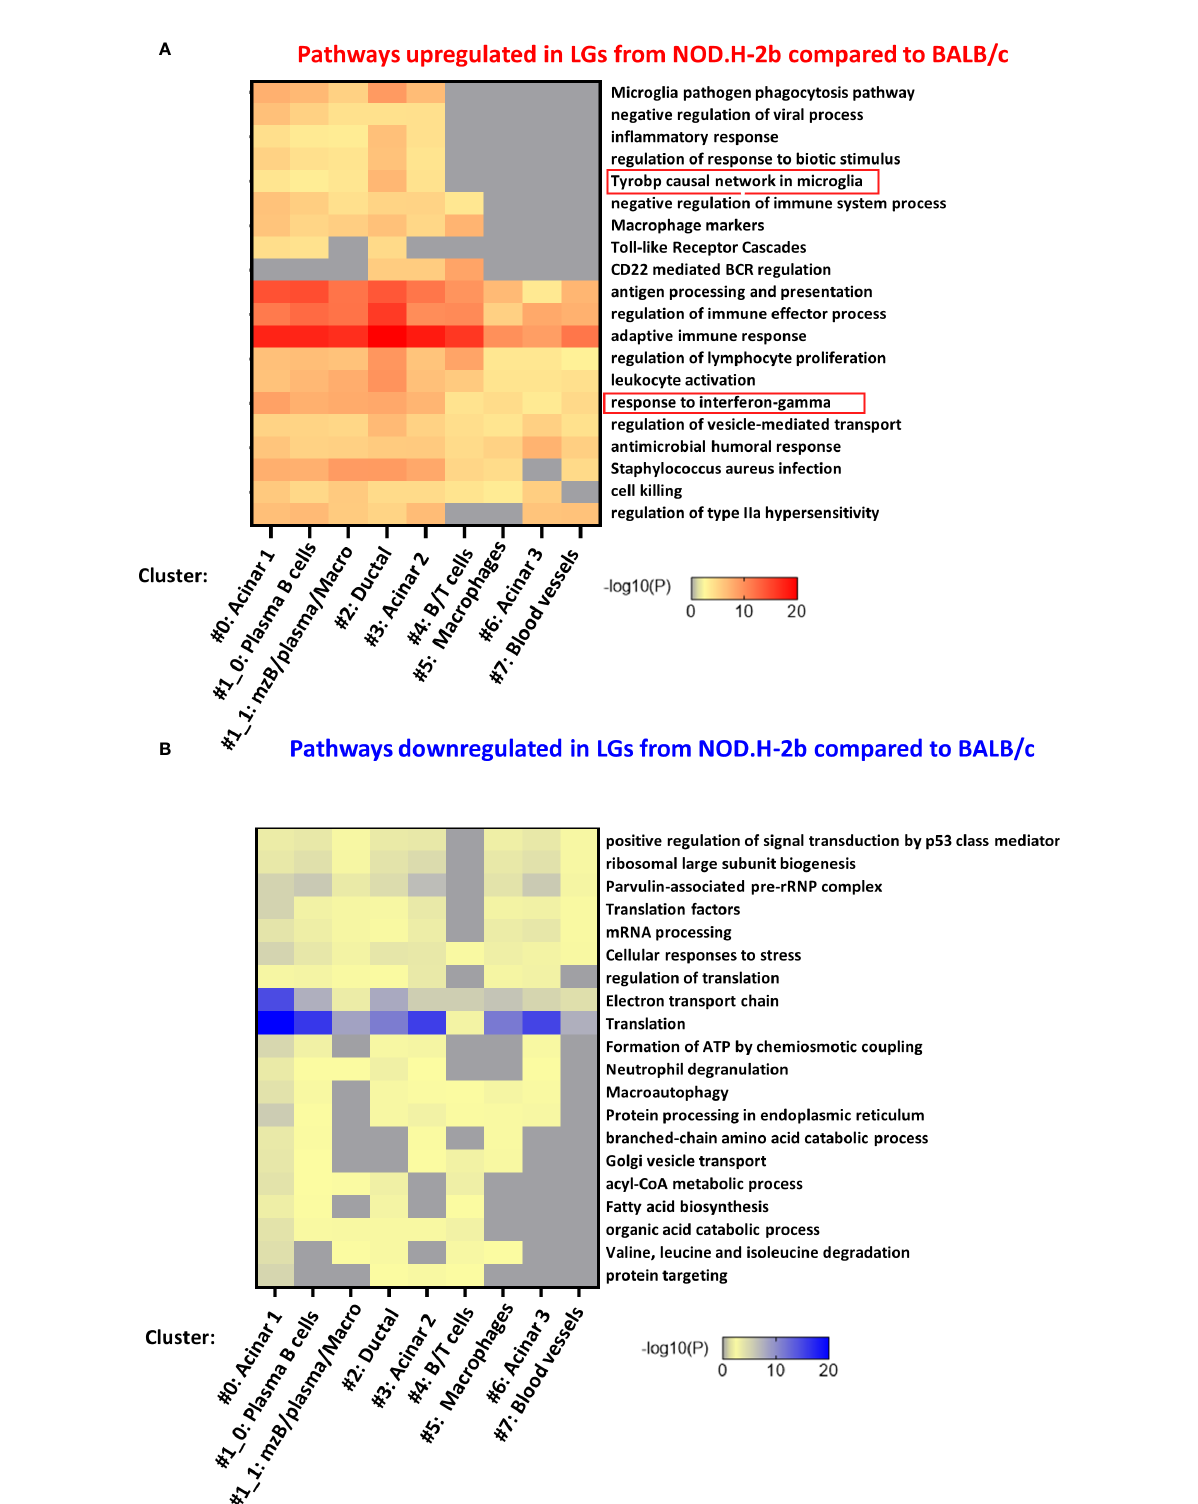
FIGURE 7 Pathway enrichment in DEGs for each cluster. The 7 lists (one for each cluster) of all (A) upregulated and (B) downregulated DEGs between NOD.H-2b_1 vs BALB/c_2 samples were submitted on www.metascape.org with default parameter (61) to identify altered pathways the most signi fi cantly enriched per cluster. The top 20 of enriched terms are presented on a heatmap based on their adjusted